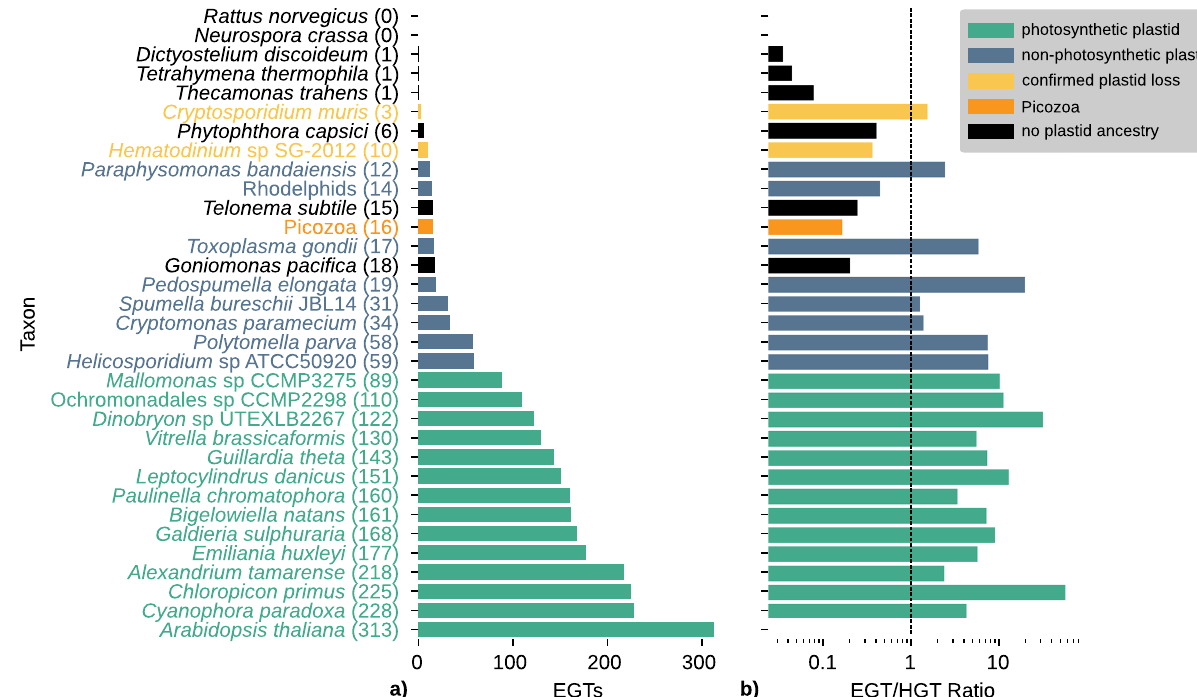
Fig. 3 Inferred endosymbiotic gene transfers (EGT) and horizontal gene transfers (HGT). a Number of inferred endosymbiotic gene transfers (EGT) across a selection of 33 species that represent groups with photosynthetic plastids (green), non-photosynthetic plastids (blue), con fi rmed plastid loss (yellow) and no known plastid ancestry (black). These species serve as a comparison to Picozoa (orange). b The number of EGTs from ( a ) is related to the number of inferred HGT across the same 33 selected species. A number below 1 indicates more HGT than EGT, while numbers above 1 indicate more EGT than HGT. No ratio could be calculated for Arabidopsis because there were no detectable HGT events. Source data are provided in Supplementary Table